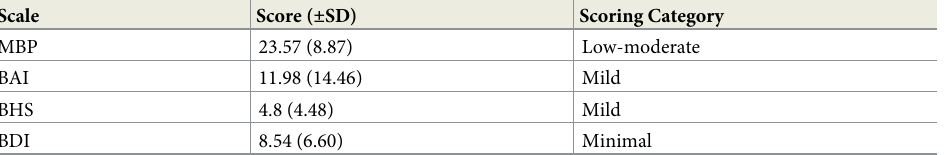
Table 2. Mean scores for Mee-Bunney Psychological Pain Assessment Scale (MBP), Beck Depression Inventory (BDI), Beck Anxiety Inventory (BAI) and Beck Hopelessness Scale (BHS).